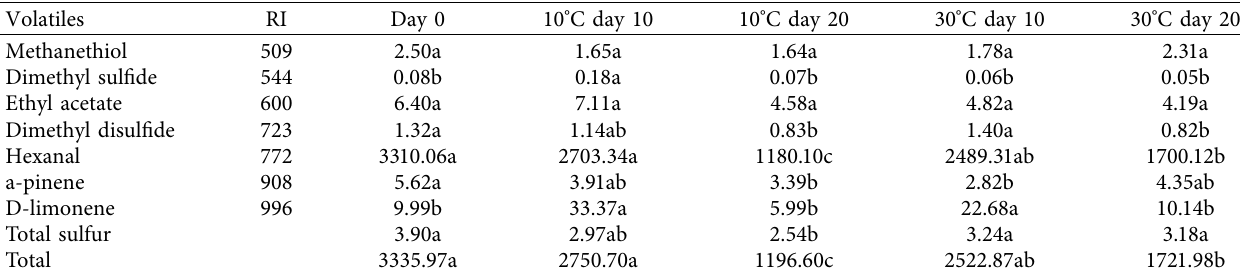
Table 2: Aroma volatiles ( μ g/L − 1 ) in winter melon juices stored under different conditions.